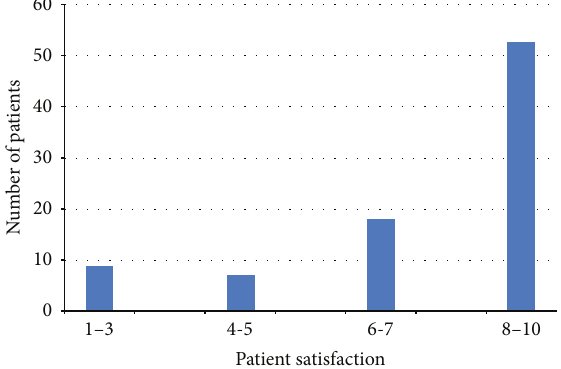
Figure 3: Patient satisfaction (1–10: 1 = extremely dissatisfied to 10 = extremely